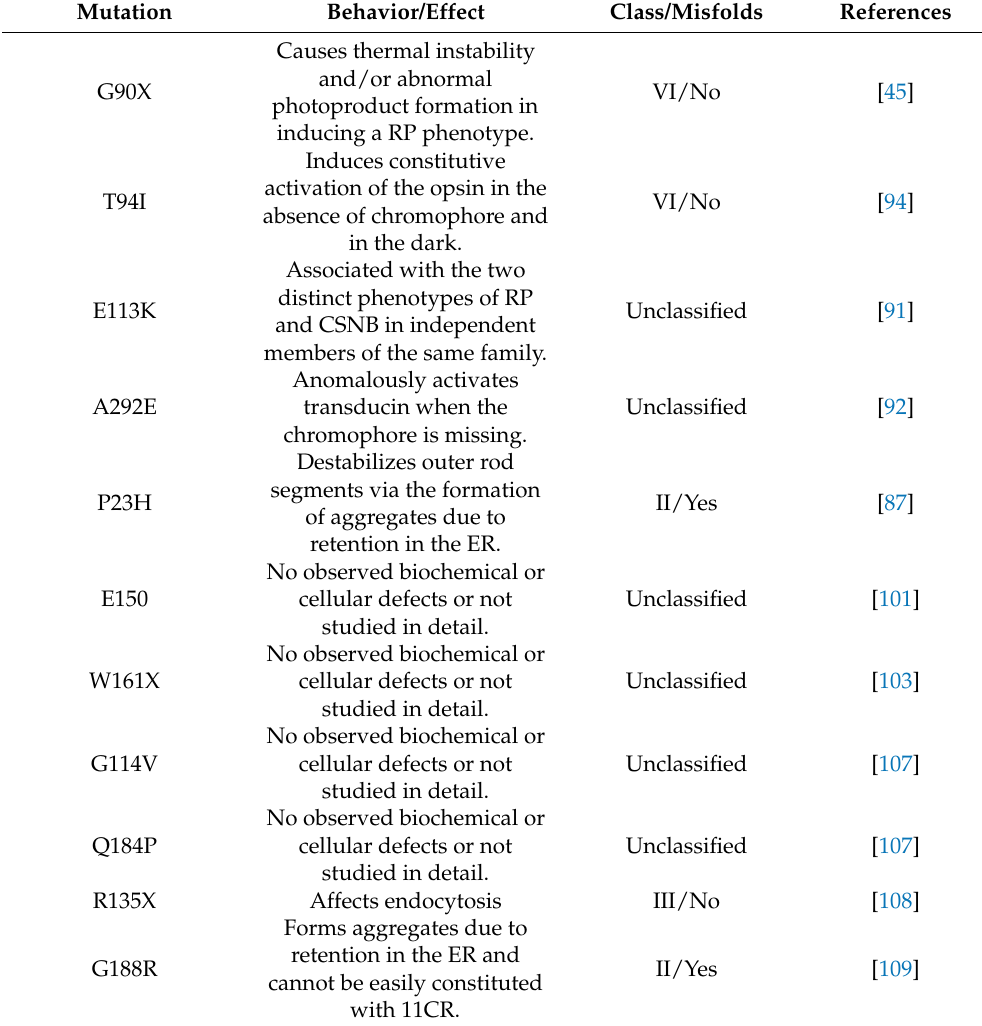
Table 1. Summary of the biochemical phenotypes of selected mutations in Rho associated with retinal degenerative diseases, namely, RP and